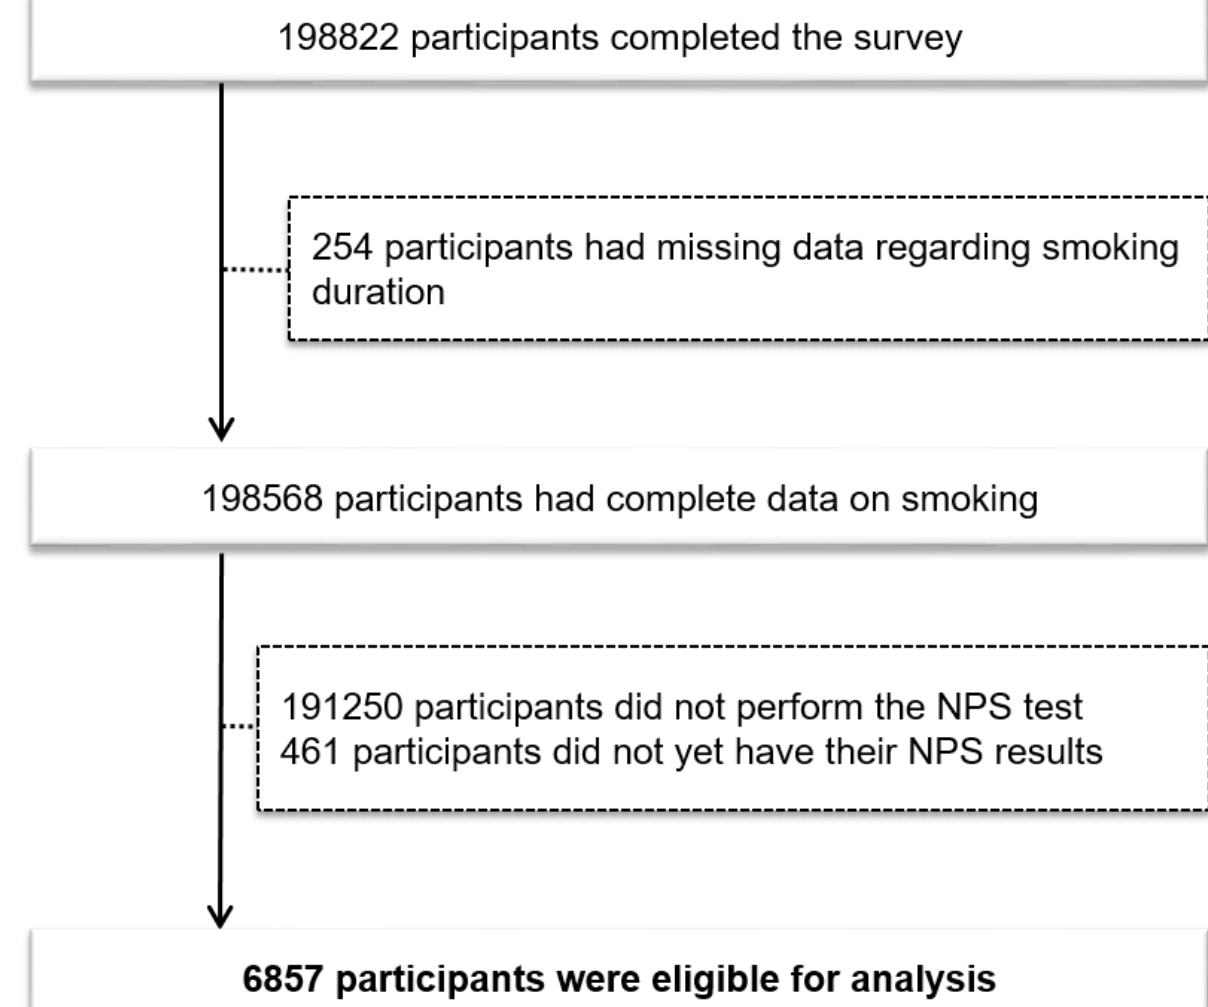
Figure 1. Flowchart of participant recruitment and eligibility for the EPICOVID19 (Italian National Epidemiological Survey on COVID-19) study. NPS: nasopharyngeal